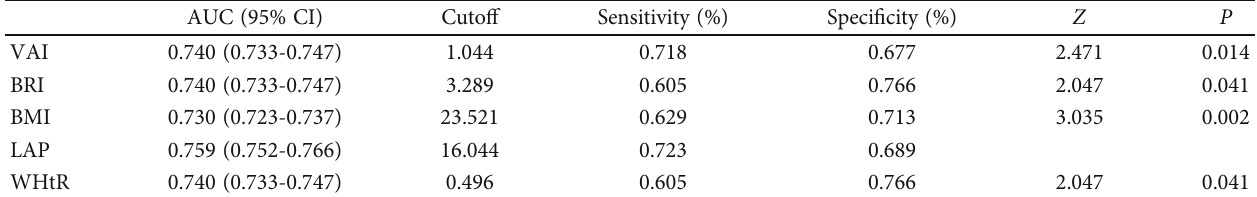
Table 2: ROC curve results of fi ve obesity evaluation markers for predicting new-onset type 2 diabetes.